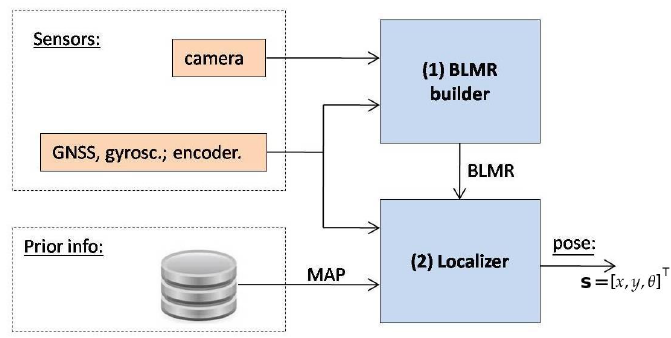
Figure 22. Data fusion strategy for vehicle’s pose estimation.